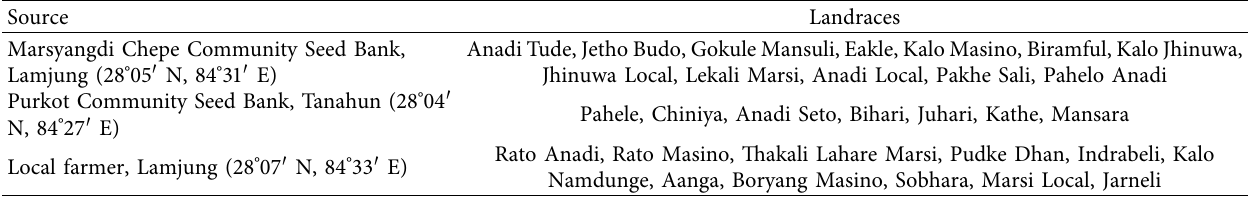
Table 1: List of landraces and site of their